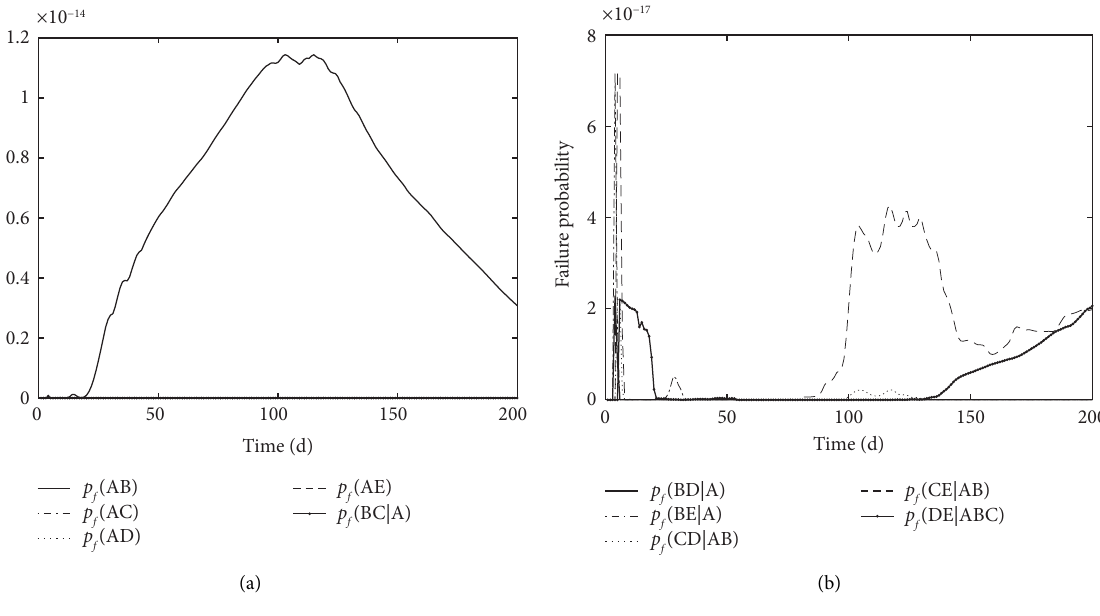
Figure 12: Failure probability of bivariate vine structure.